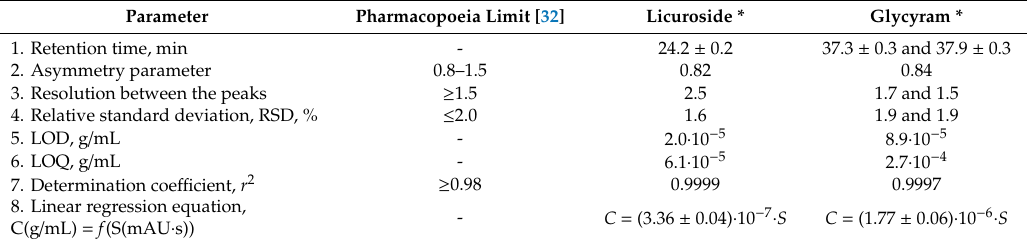
Table 2. Main parameters of analytical method validation and RP HPLC system suitability for licuroside and glycyram determination.